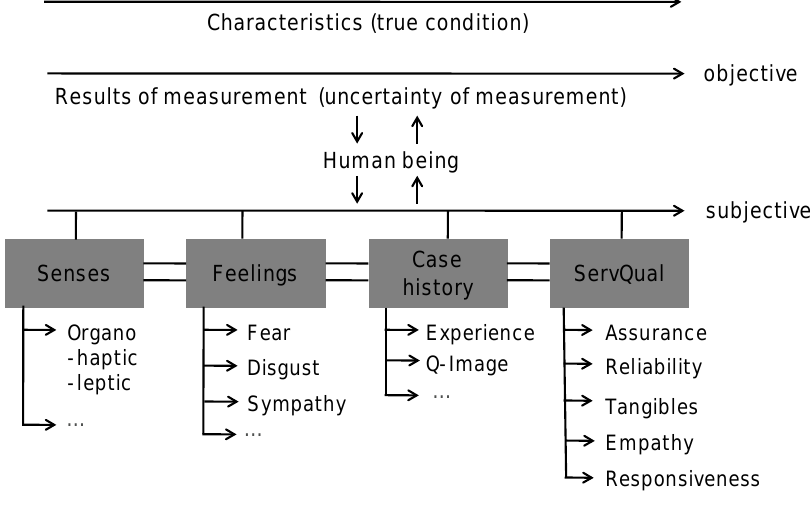
Figure 6. Structuring in line with the dimension “weighted level of